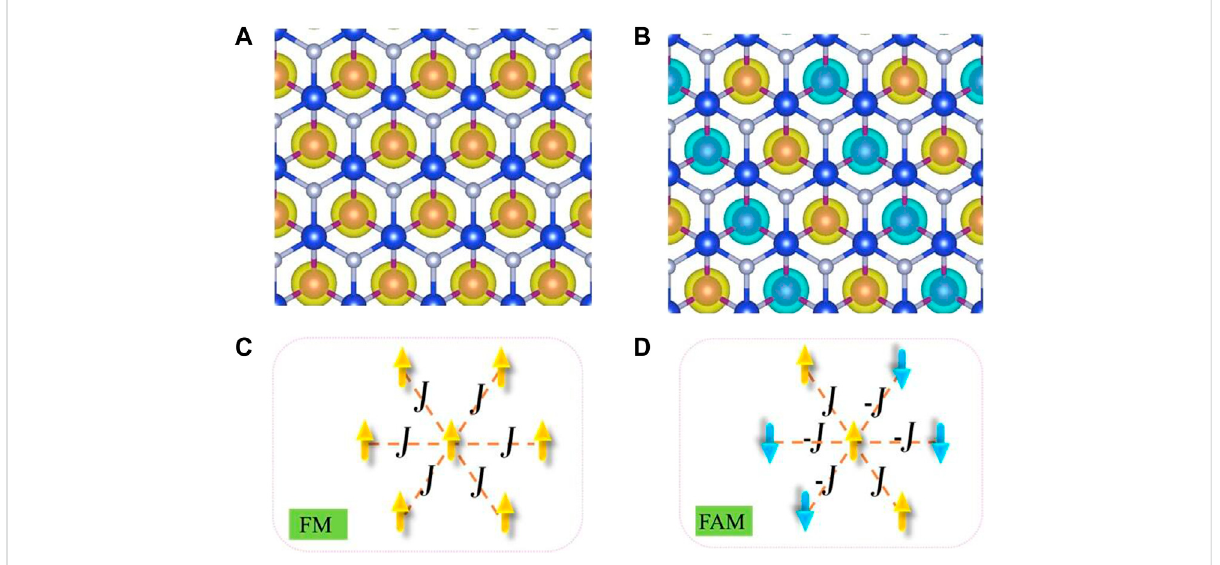
FIGURE 3 (A,B) spin-polarized charge densities of the FM and AFM case for MnSi 2 N 4 . The yellow and light blue isosurface with an isosurface value of 0.05 e/Bohr 3 represent the spin-up and spin-down charge densities, respectively. (C,D) The scheme represents spin orientation of Mn atoms in FM and AFM